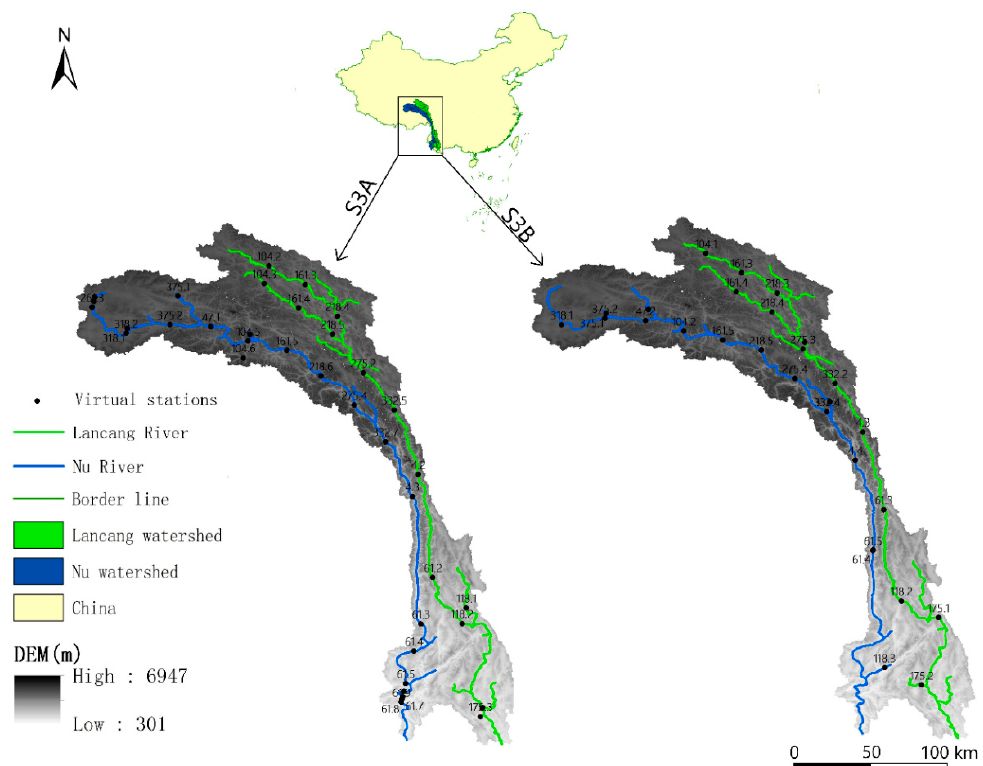
Figure 1. Base map of the study area, including DEM information of the watershed and the locations of virtual stations on major rivers. The left map shows the location and number of sentient ‐ 3A (S3A) virtual stations. The right map shows the location and number of the sentient ‐ 3B (S3B) virtual